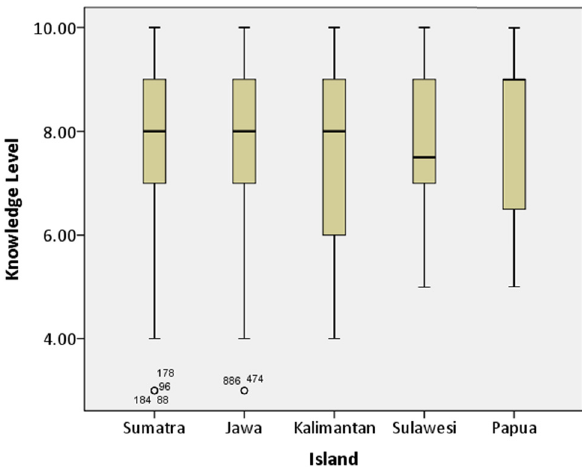
Figure 6: Student ’ s knowledge level by island.